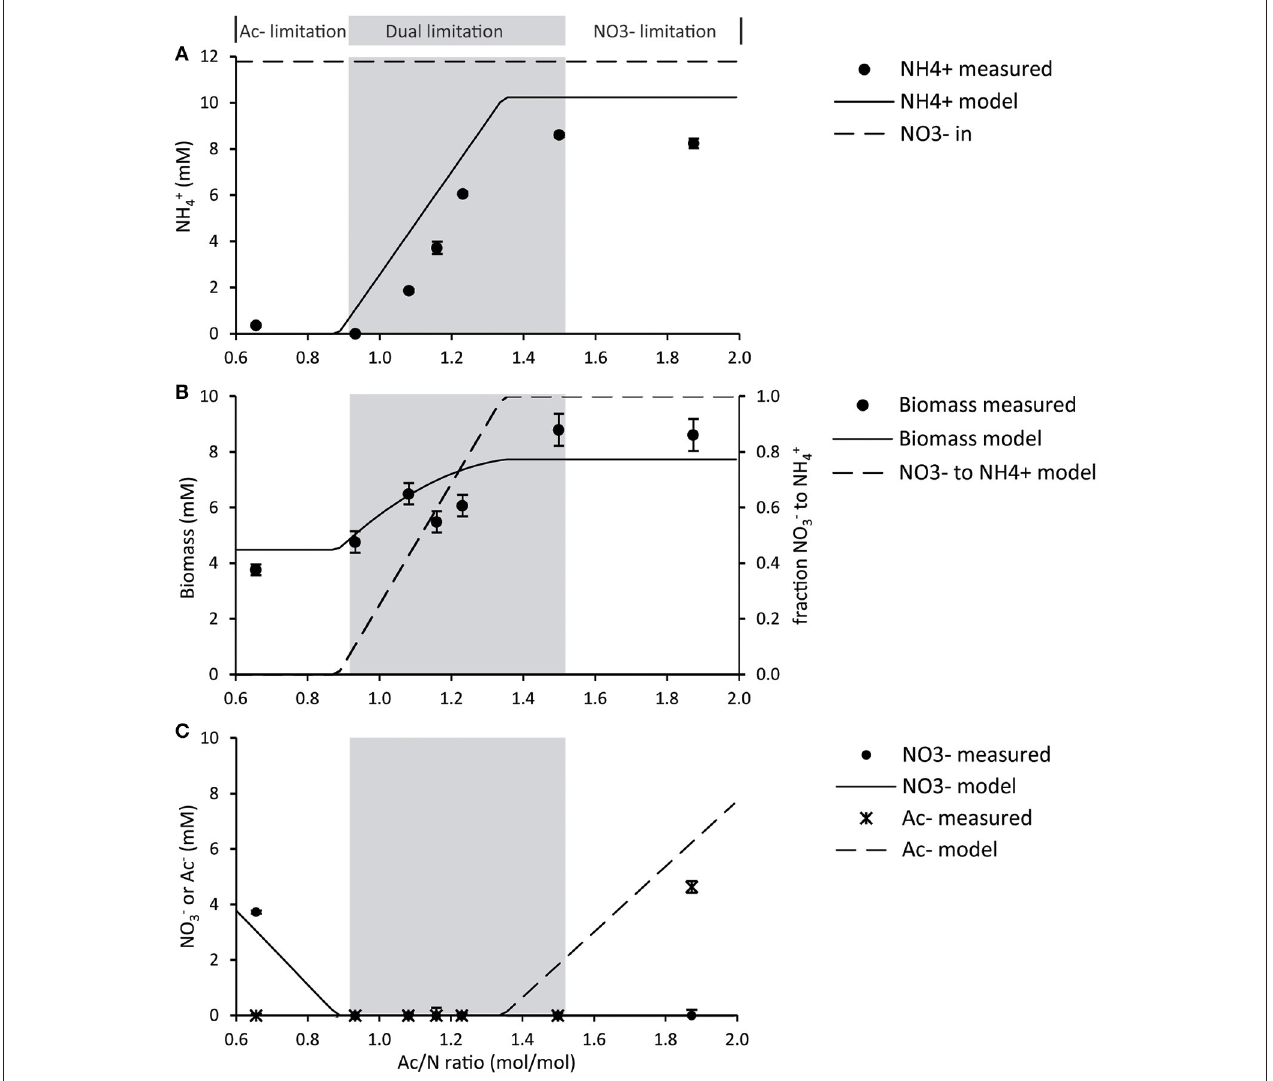
FIGURE 1 | Steady state reactor concentrations were measured for each cycle. Average deviations were obtained from daily measurements during the steady state ( n > 3). (A) Ammonium concentrations measured and modeled for different Ac/N ratios. As a reference, the influent nitrate concentration is shown. (B) Biomass concentrations measured and modeled. The modeled fraction of DNRA biomass is shown for reference. (C) Nitrate and acetate concentrations, measured and modeled.